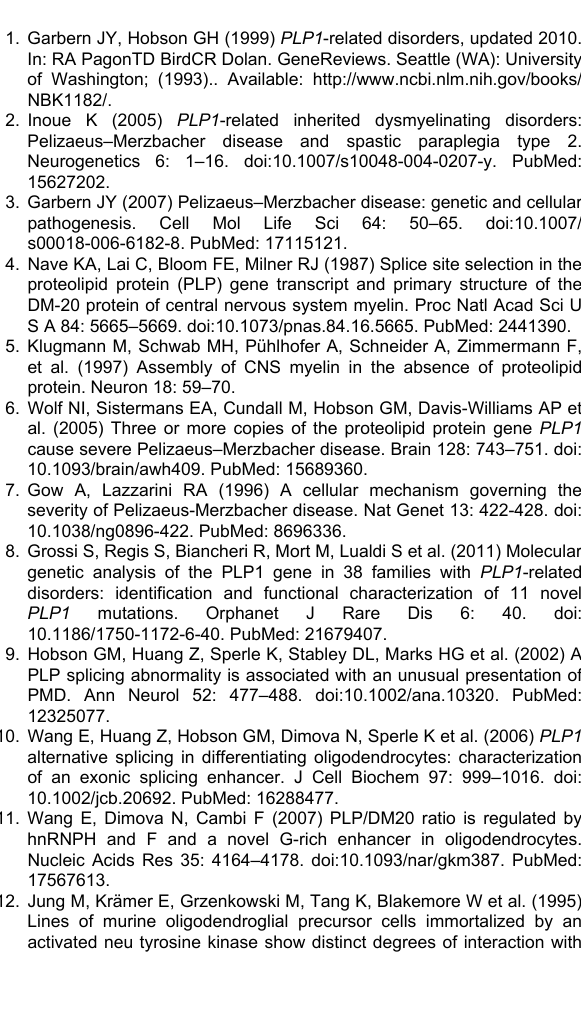
Table S1. Evolutionary comparison of the PLP1 protein intracellular loop flanking the L146V missense mutation with their orthologous counterparts in seven